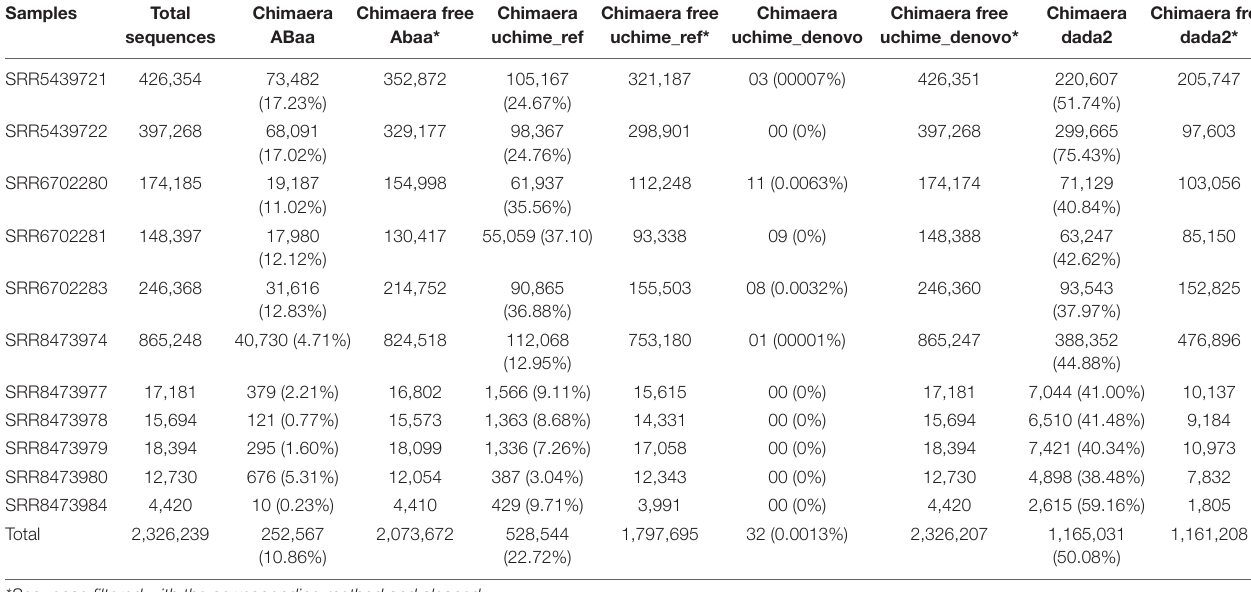
TABLE 2 | Level of detection of chimaera removal methods. Samples